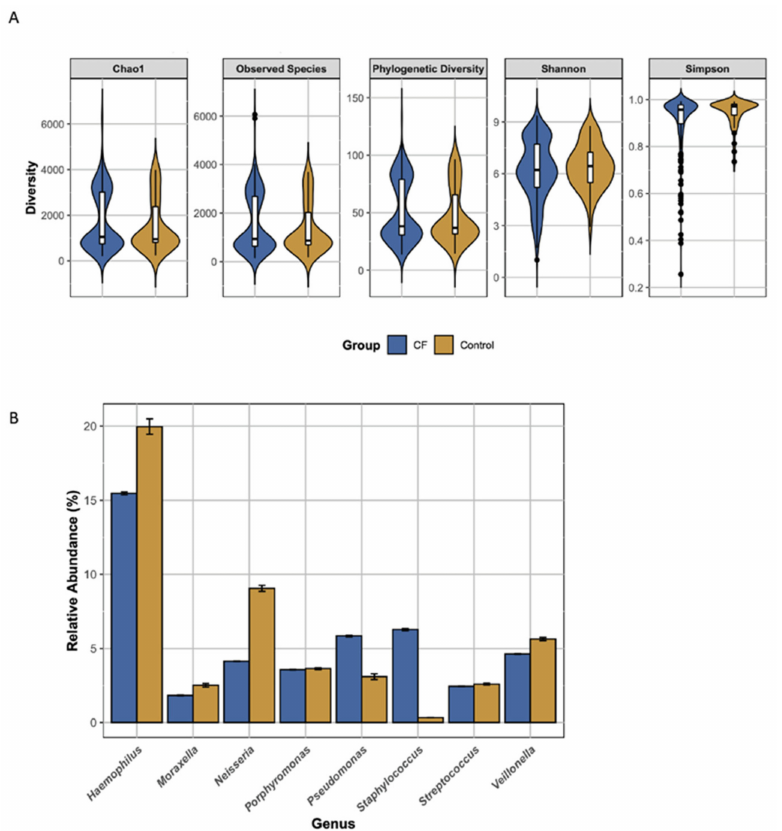
Figure 2. Comparison of the CF and control lung microbiome. ( A ) Violin plots of alpha diversity measures. ( B ) The percentage relative abundance of genera which were significantly differentially abundant between cohorts (i.e., LDA > 4) as determined by LEfSe (error bars show standard error). 3.4. The CF and Control Airway Microbiomes Are Disparately Associated with Age in the First Years of